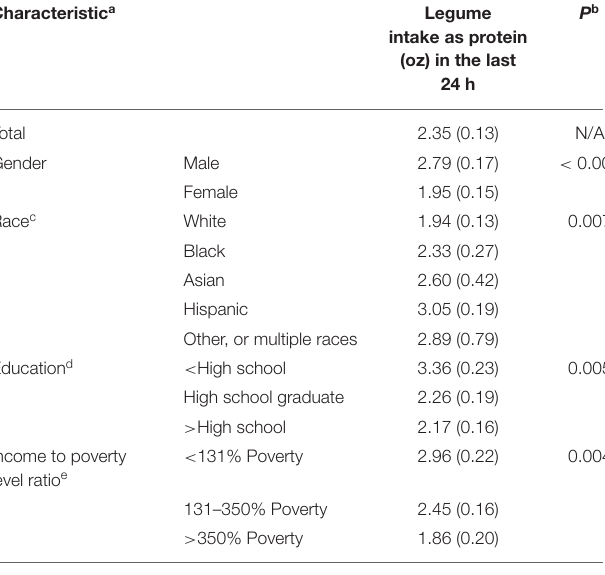
TABLE 1 | Characteristics of adults ( ≥ 20 y) who reported consuming legumes on a single dietary recall in the National Health and Nutrition Examination Survey, 2017–2018. Characteristic a